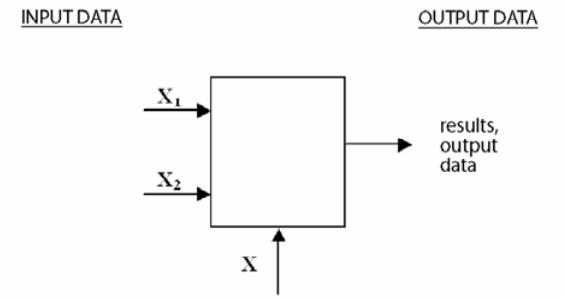
Fig 2. Experiment plan for static tests. Input data: X – constant factors: wood species, moisture content, X1 – va- riable factors – saturation status: saturated = 1, non- saturated = 0, X2 – variable factor: temperature during tests. Output data: static strength